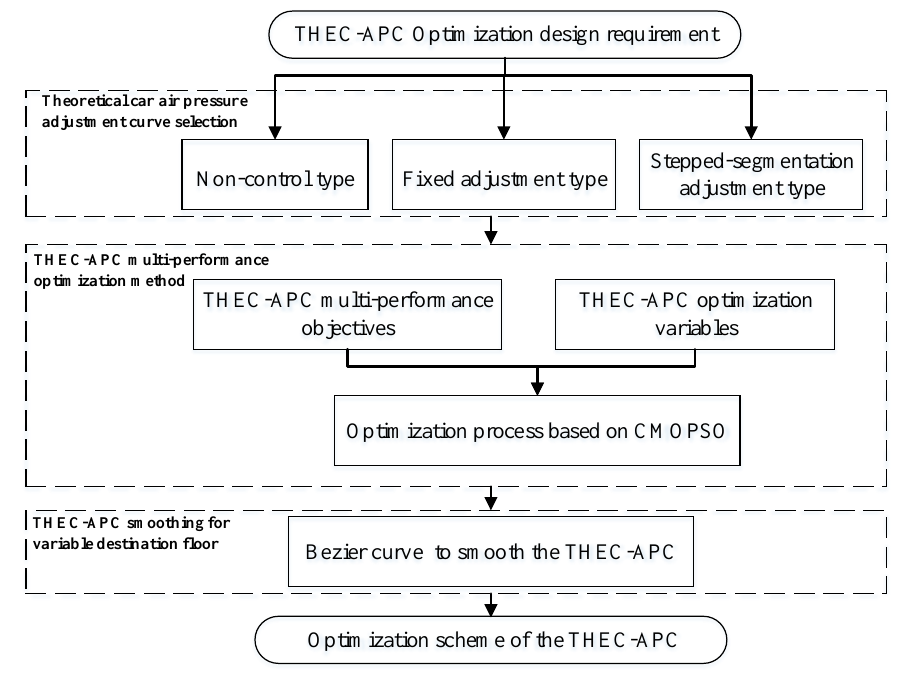
Figure 1. Introductory paragraph of the proposed method.